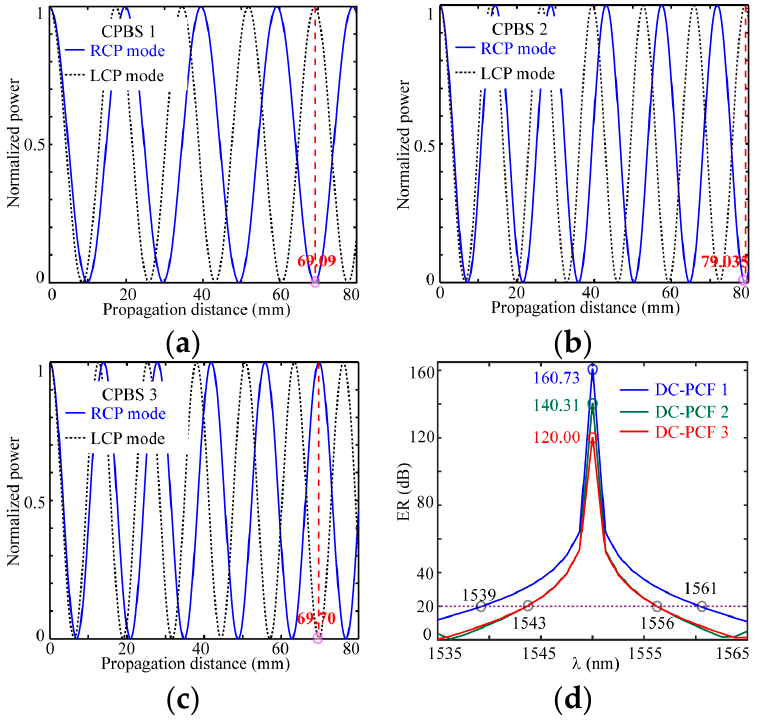
Figure 8. Normalized power in port A along propagation distance in the chiral PCF CPBSs in ( a – c ) and the corresponding dependence of the ER on wavelength in ( d ). Table 1. Performance comparison between the proposed chiral DC-PCF CPBS and the reported chiral DC-PCF